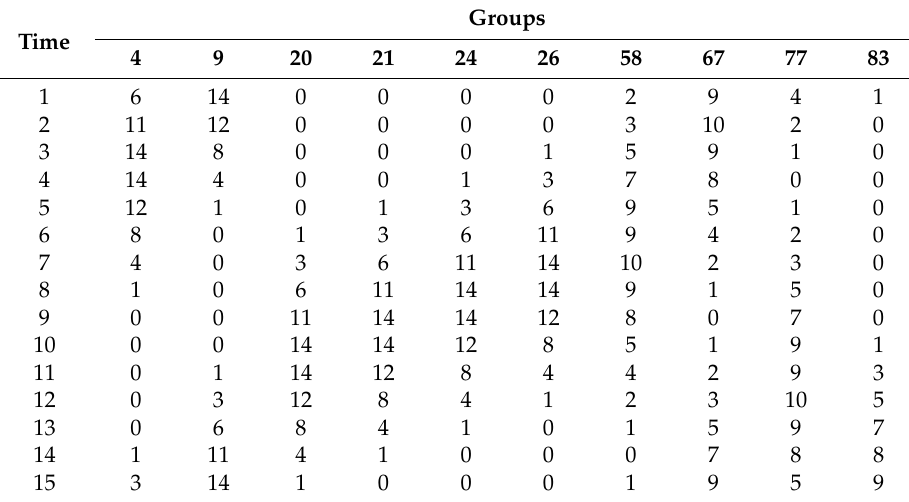
Figure 10. Twenty-four hour wind power output tracking.